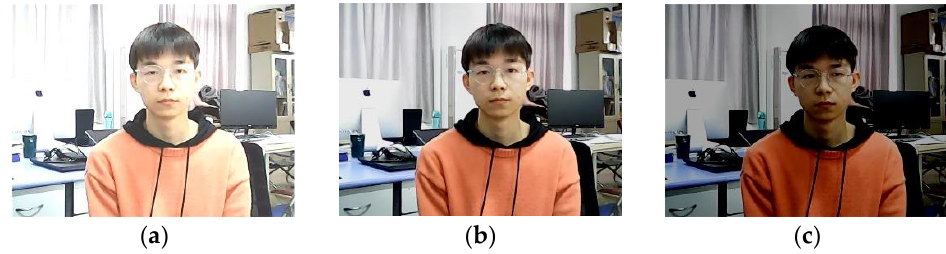
Figure 5. Examples of live faces in self-built dataset. ( a ) High light. ( b ) Normal light. ( c ) Dark light.